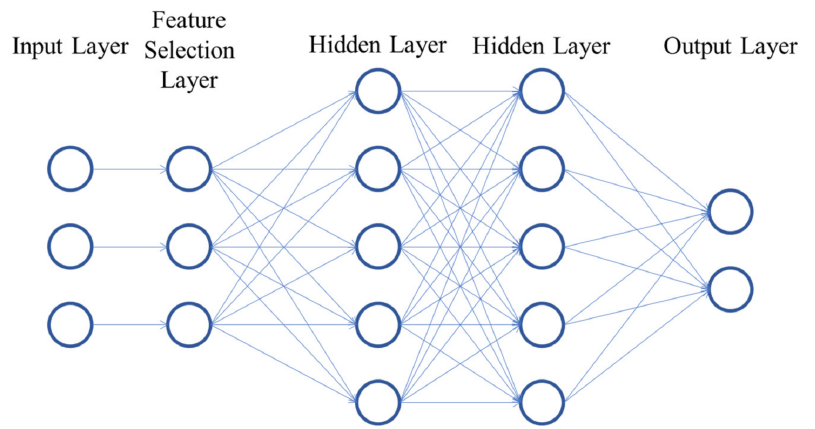
Figure 5. An example of a deep neural network with the proposed FS